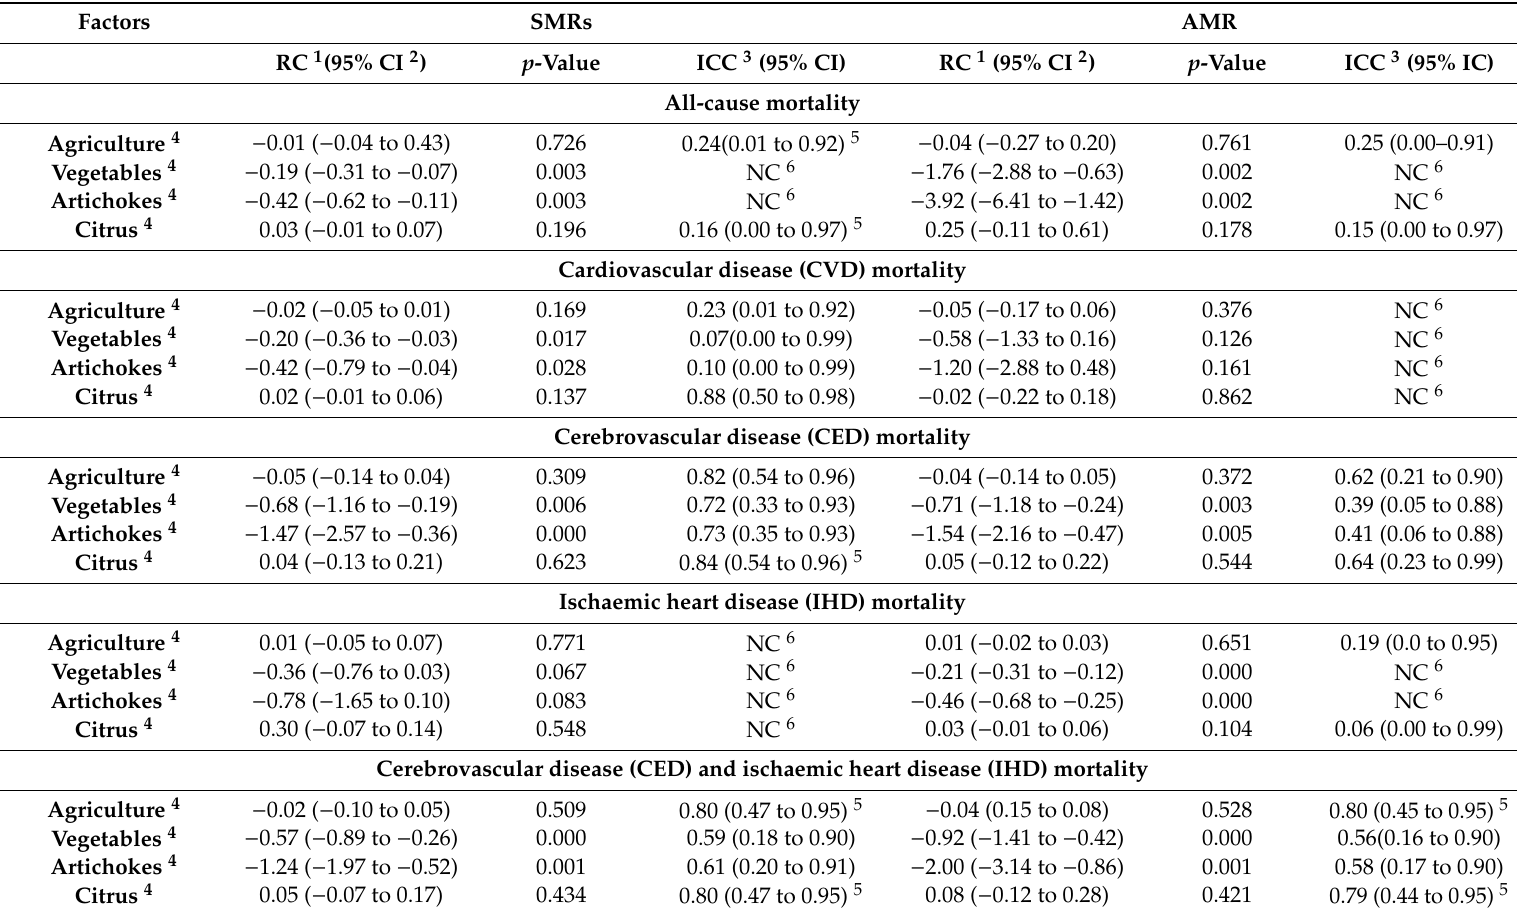
Table 6. Multilevel linear regression: smoothed standardized mortality ratio (SMR) and age-adjusted mortality rate (AMR) of mortality among eight municipalities of the Castell ó n province. Adjusted models for sex, population aged 65 years and above, foreign-born, household income, illiteracy level, and municipality (Castell ó n, 1991–2011